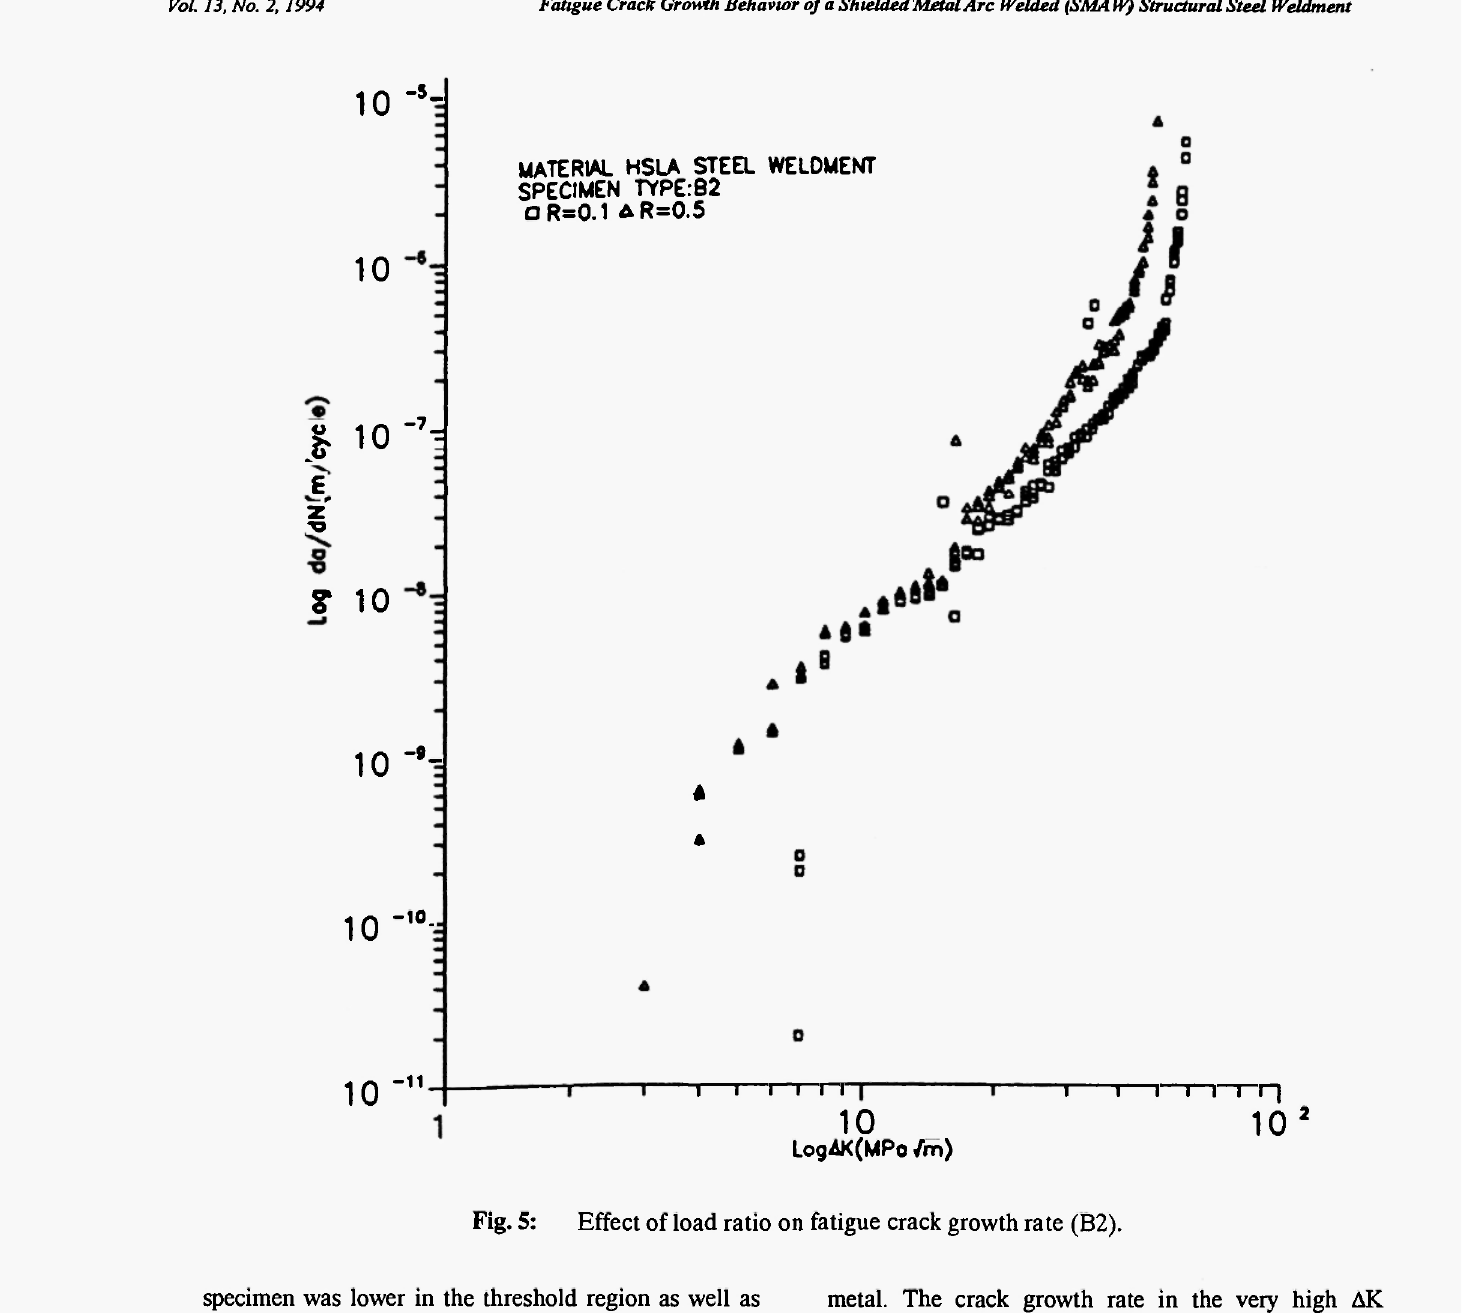
Fig. 5: Effect of load ratio on fatigue crack growth rate